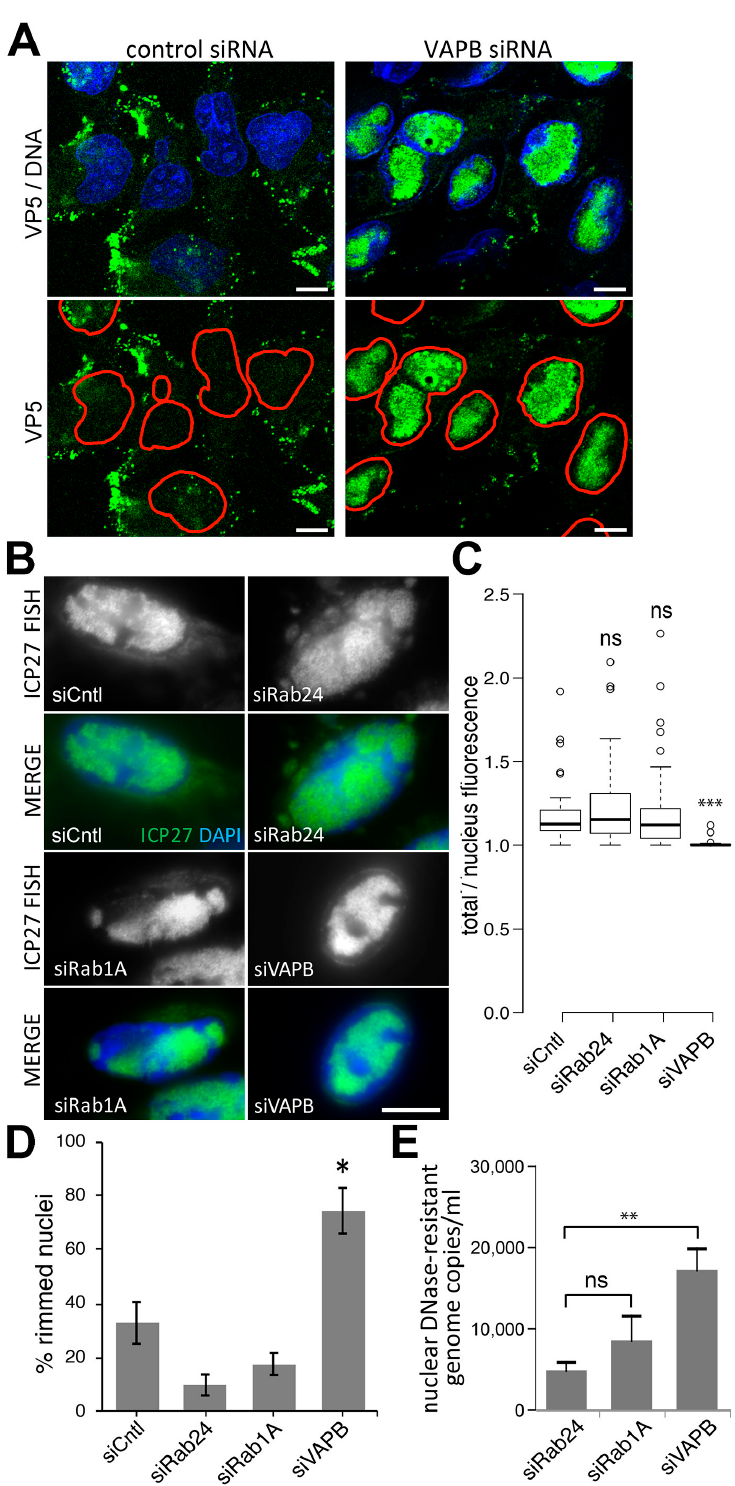
Figure 6. FISH and immunofluorescence also indicate accumulation of nuclear and peri-nuclear virus particles in VAPB knockdown cells. ( A ) Immunofluorescence staining for capsid protein VP5 at 16 hpi with an MOI = 10 reveals an altered distribution to acccumulate in the nucleus with VAPB knockdown. In the lower panels, the edge of the nucleus defined by DAPI staining of the DNA is marked by a red line so that a portion of the VP5 in the nucleus can be observed in the control knockdown cells, as expected. ( B ) The virus gene ICP27 was used as a FISH probe and labeled with biotin. Cells were knocked down for VAPB and controls Rab24, Rab1A and non-target siRNA, infected with HSV-1 and